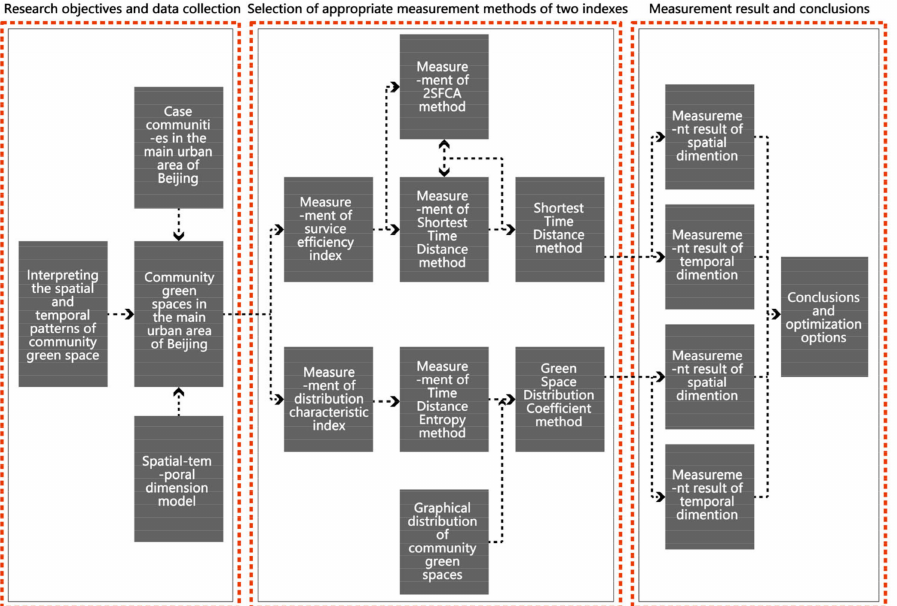
Figure 6. The research framework of the paper.